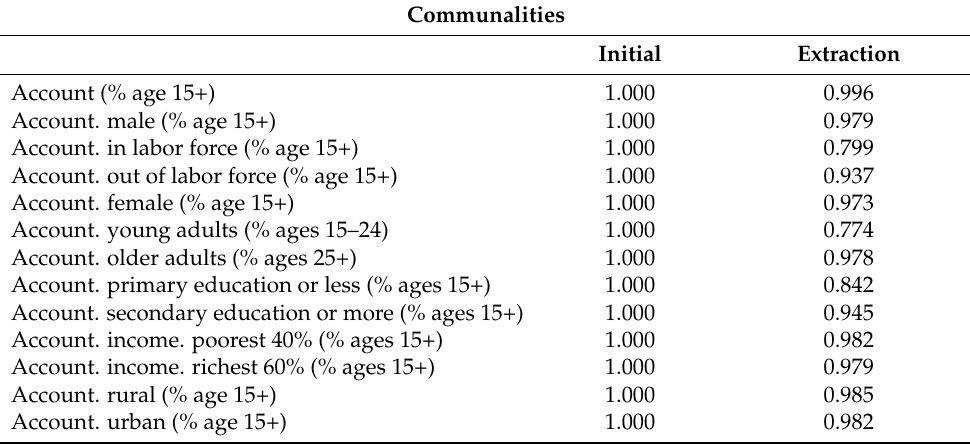
Figure 4. Component plot. Table 1. Eigenvalue.